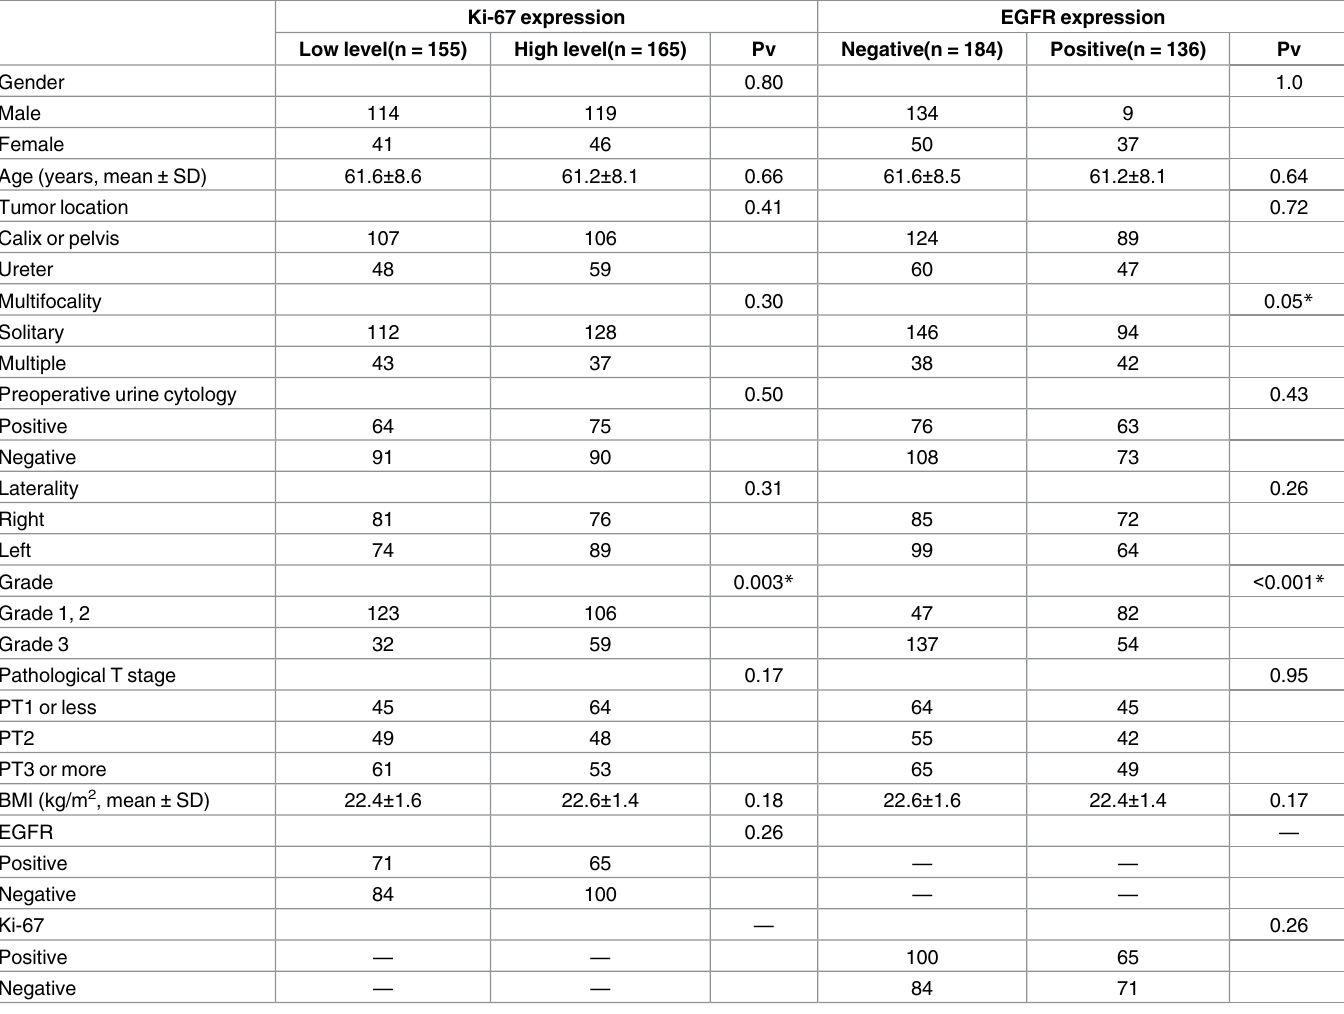
Table 2. Association between EGFR / Ki-67 Expression and Clinicopathological Parameters in 320